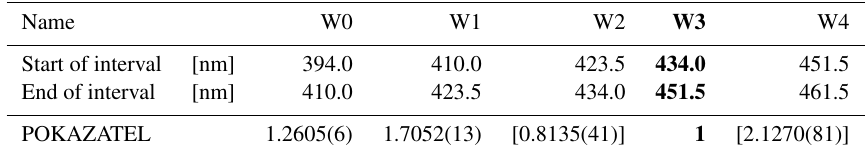
Table 7. Measured relative absorption-band strengths for the different cross sections with respect to the absorption at W3 (the 7 ν polyad; column in bold). Errors obtained from the linear regression are shown for the last digits in brackets. The relative DOAS fit errors are listed in Table 8. Results with typical DOAS fit errors of more than 25% of the measured values were put in square brackets. MAX-DOAS values are corrected by the results of radiative transfer modelling (Lampel et al.,